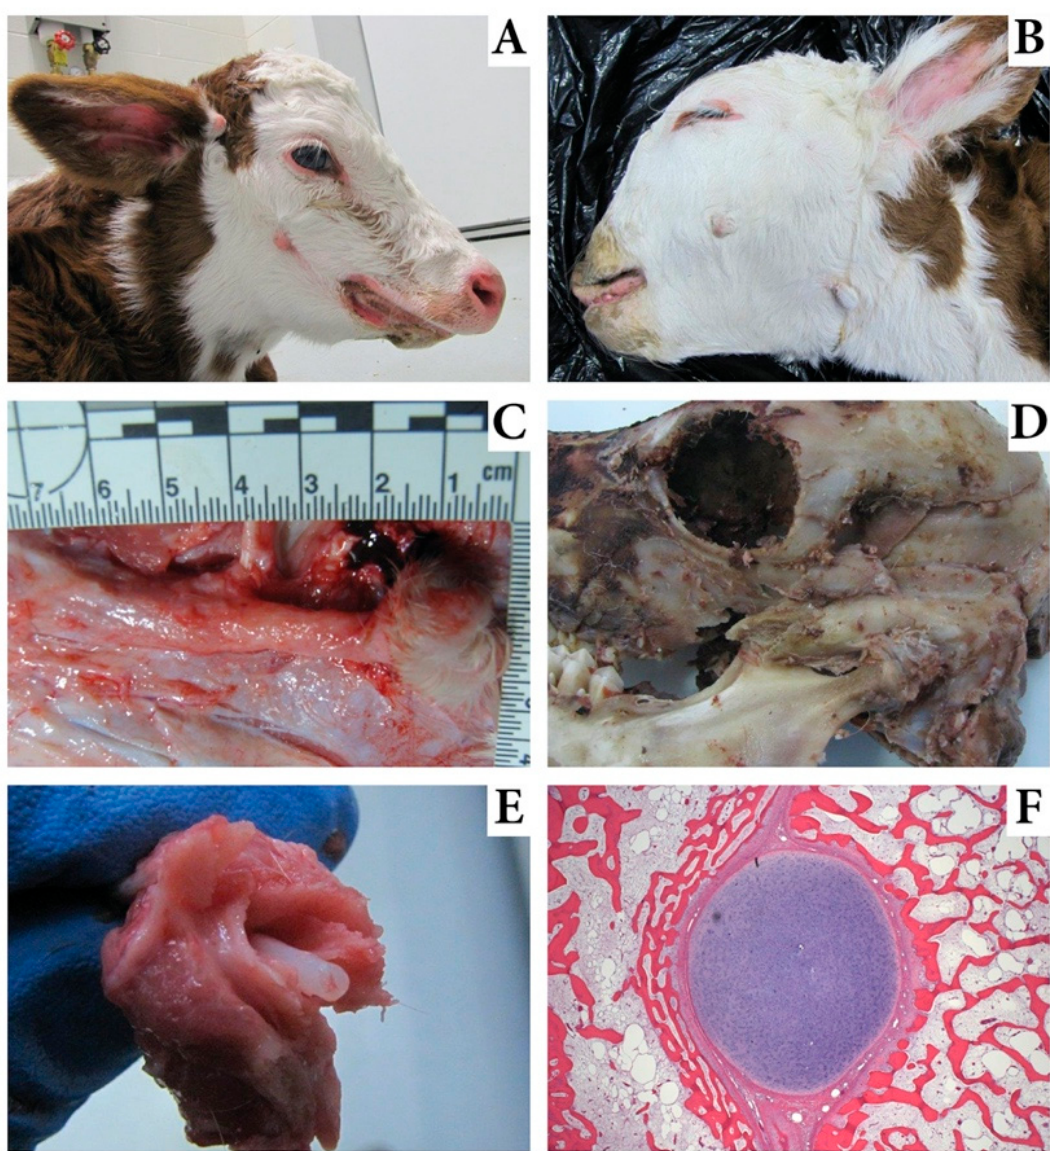
Figure 1. Images of calves a ff ected with mandibulofacial dysostosis (MD). ( A ). An MD calf with megastomia. Skin tags are visible ventral to the eye and at the base of the ear. Brachygnathia is also evident and a slight facial bulge is seen dorsal and caudal to the skin tag. ( B ). An MD calf with skin tags; one is caudal to commissure of the lips and one is ventral to the base of the ear near the caudal ramus of the mandible. ( C ). Exposure of the abnormal bone in an MD calf with the skin tag intact at the right margin. ( D ). The skull of an MD calf showing the exposed bone fractured during autopsy and demonstrating origin of this abnormal bone just above the temporal mandibular joint. ( E ). An image of the fractured bony prominence in an MD calf exposing the retained Meckel’s cartilage within the bony prominence. ( F ). Histology evaluation of the Meckel’s cartilage core from an MD calf surrounded by bone and separated by fibrous tissue.